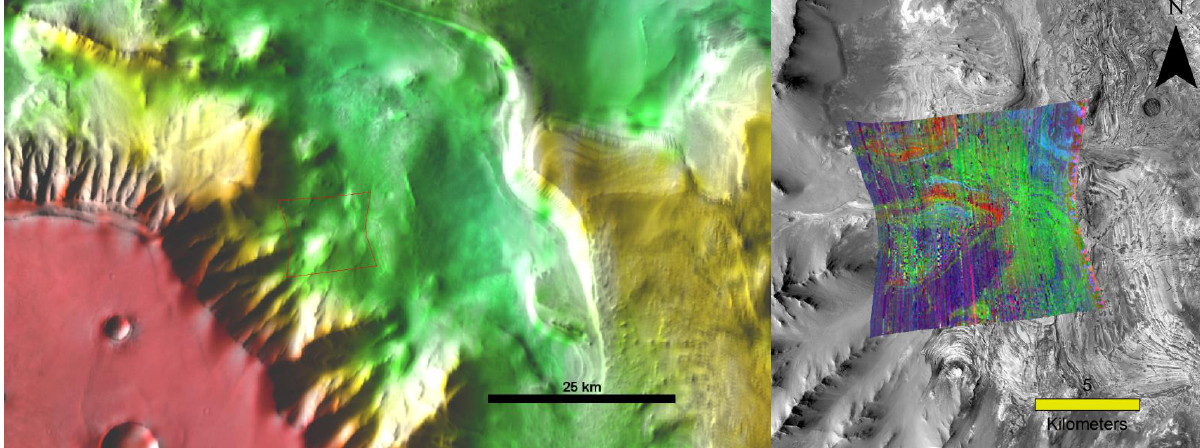
Figure. 1. Southwest Melas Chasma. (a) Regional context. The hill shaded map is produced from THEMIS day IR with MOLA color, the red outline is footprint of CRISM FRT00013F5B. (b) FRT00013F5B spectral parameters map overlain on CTX (R:BD2265, G: SINDEX, B: BD2100). North is up in both